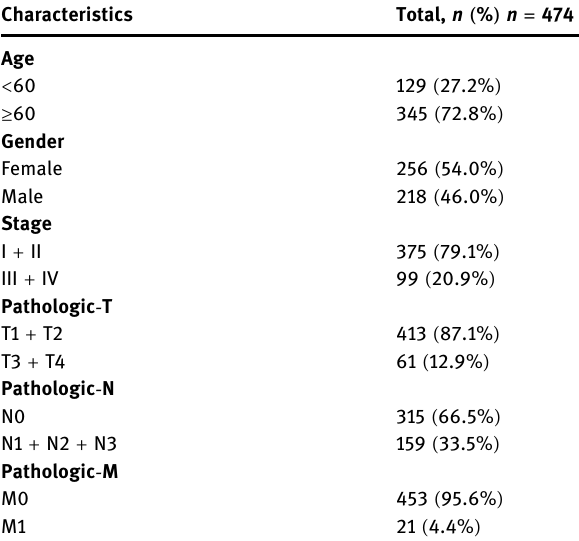
Table 1: Clinical data of LUAD patients in this work